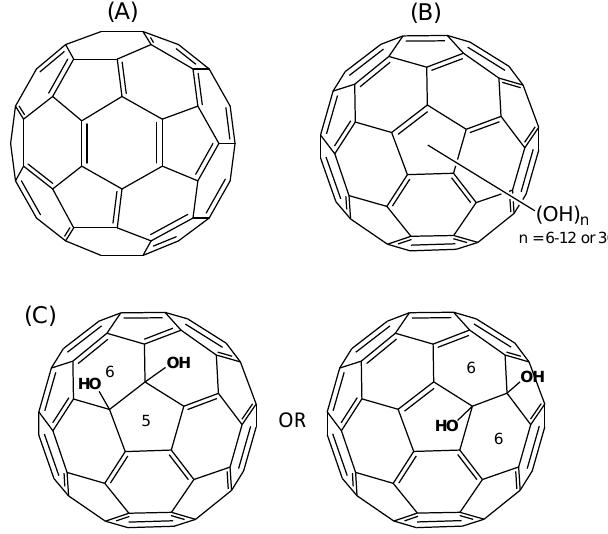
( A ); C (OH) 60 60 6–12 or 36